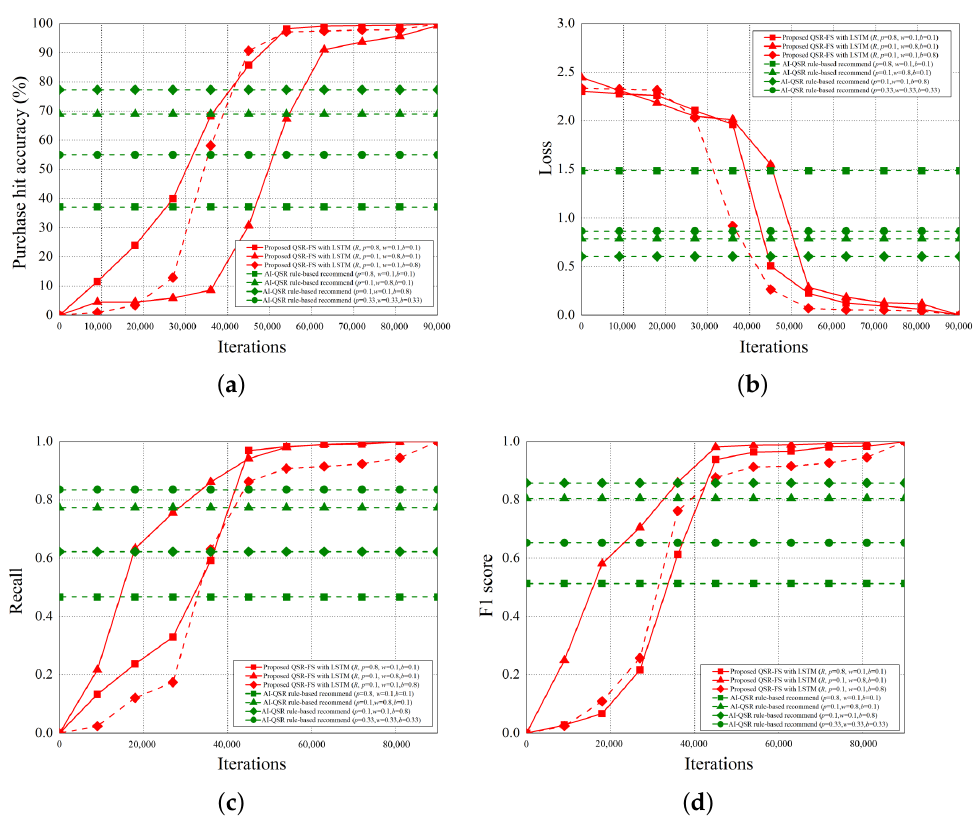
Figure 21. The comparison of iteration between different analysis metrics. ( a ) Purchase hit accuracy vs. per iteration. ( b ) Categorical cross-entropy loss vs. per iteration. ( c ) Recall vs. per iteration. ( d ) F1 score vs. per